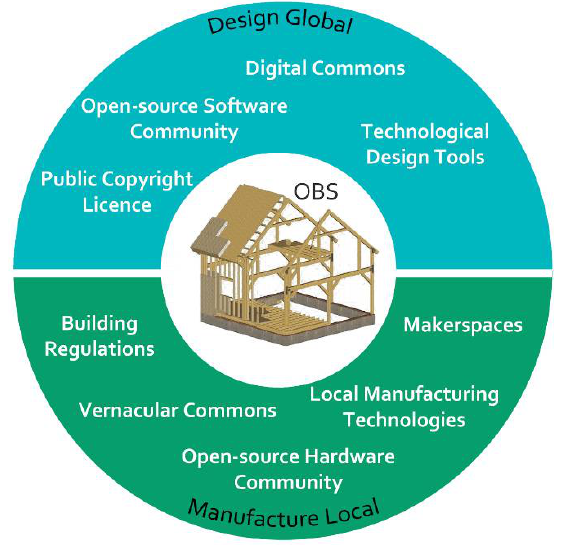
Figure 2. Conceptual framework of OCSs.